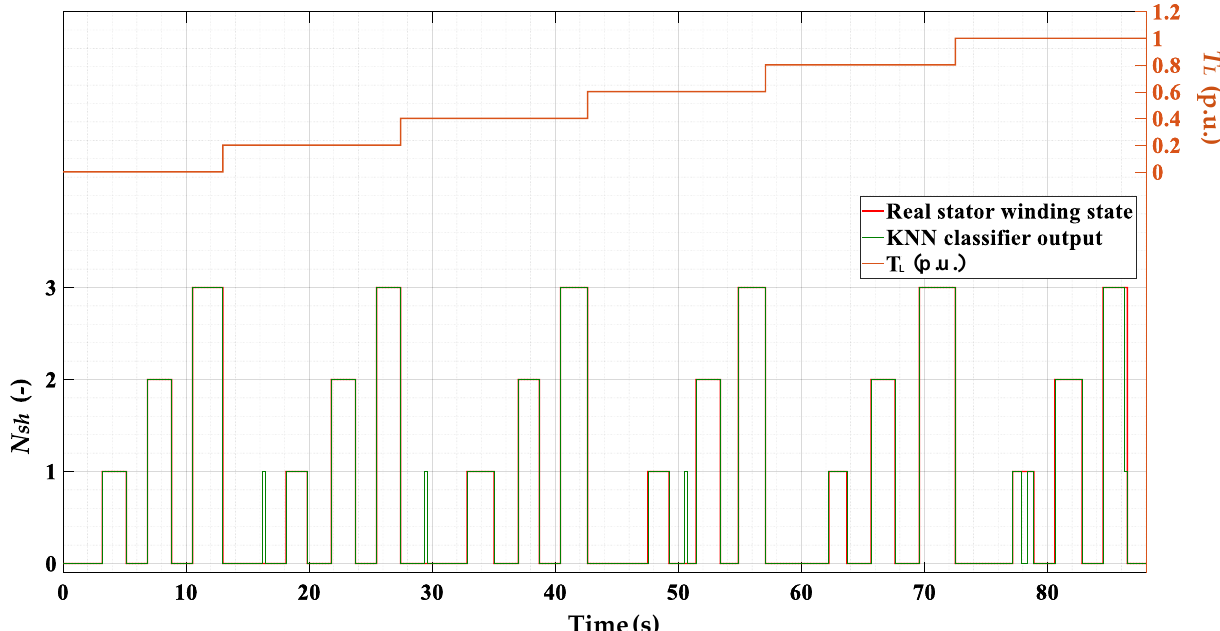
Figure 15. KNN-based stator winding fault classifier responses during the on-line operation—Test 2 ( f s = 100 Hz, T L = var).